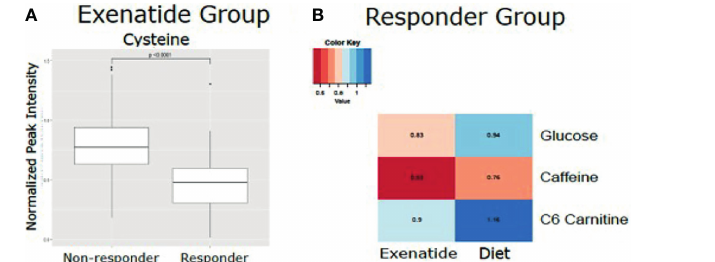
FIGURE 4 | (A) Mean normalized LC-MS peak intensity for cysteine, the only metabolite that was statistically different based on Wilcoxon Rank Sum test, between non-responder and responders in the Exenatide treated group. (B) Heatmap depicting the differences in metabolite levels, as measured by LC-MS peak intensity, that were statistically different (p<0.05) by Wilcoxon Rank Sum test between responders in the Exenatide and Diet treated groups.